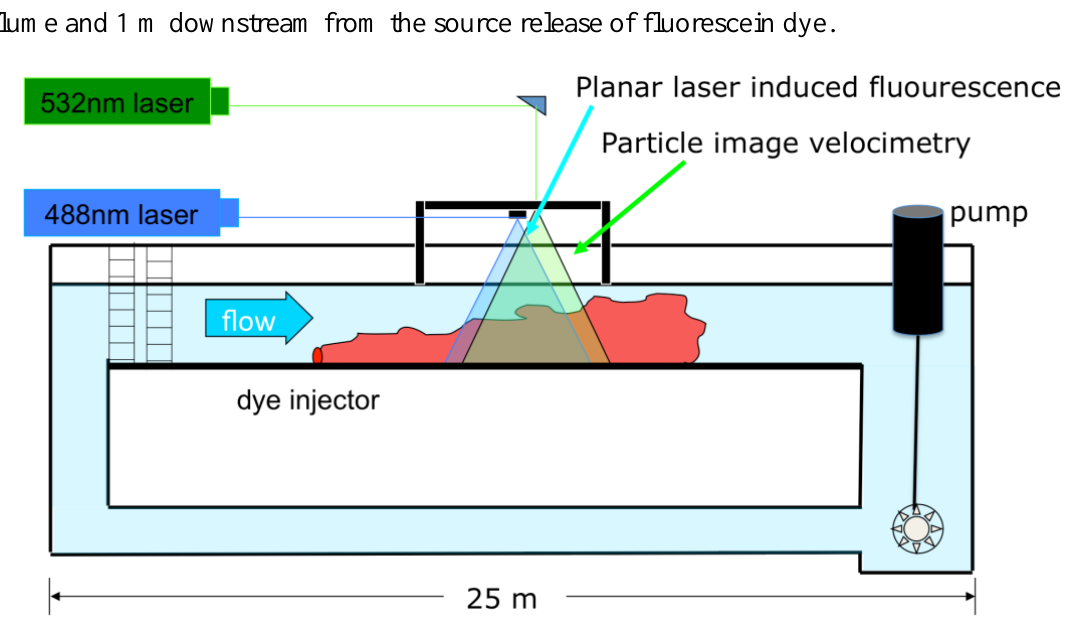
Figure 2. Recirculating flume with PLIF/PIV laser system. A 532 nm laser was used